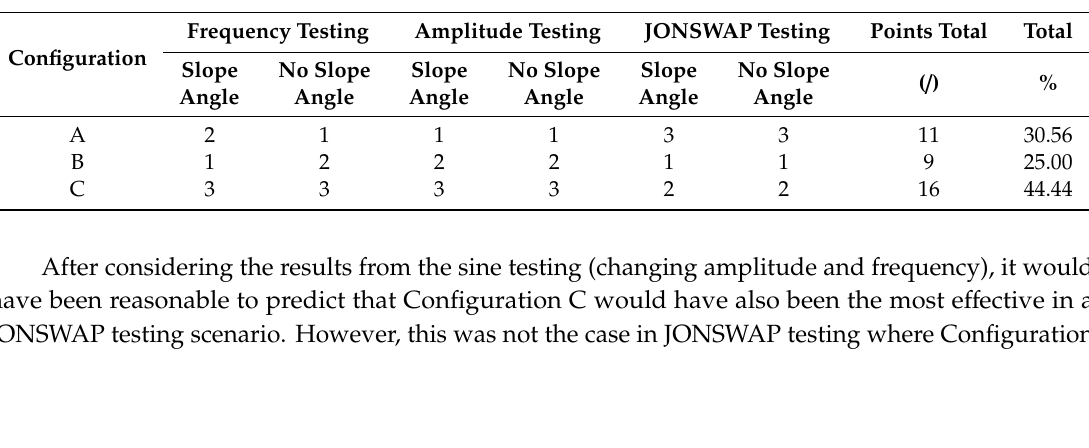
Table 7. E ff ectiveness